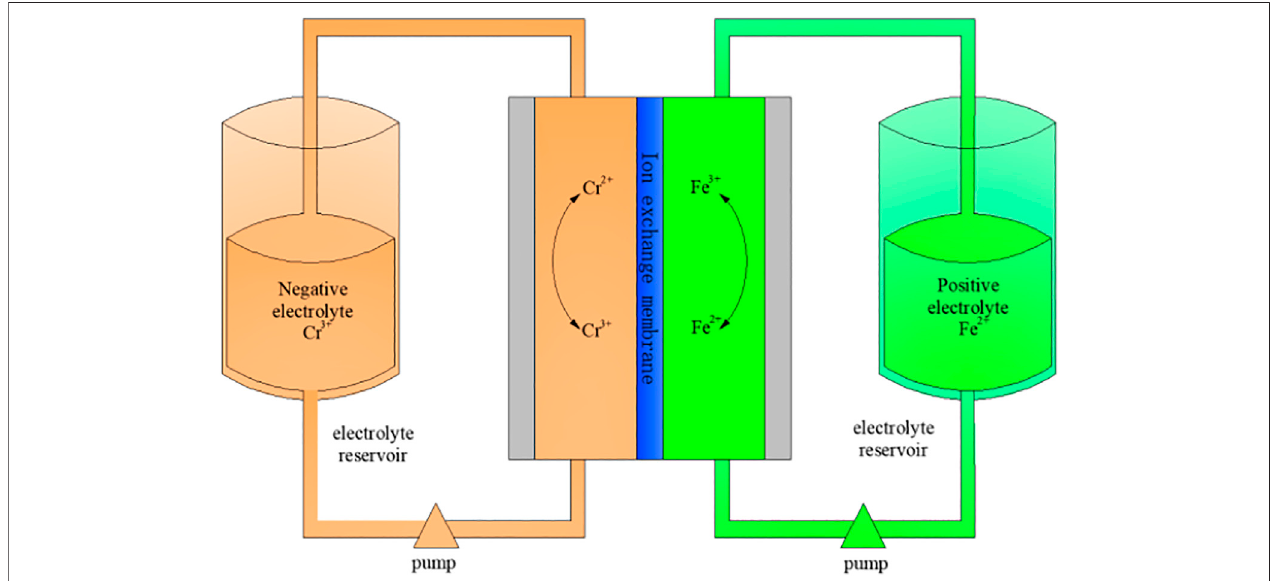
FIGURE 1 | Composition diagram of iron-chromium fl ow